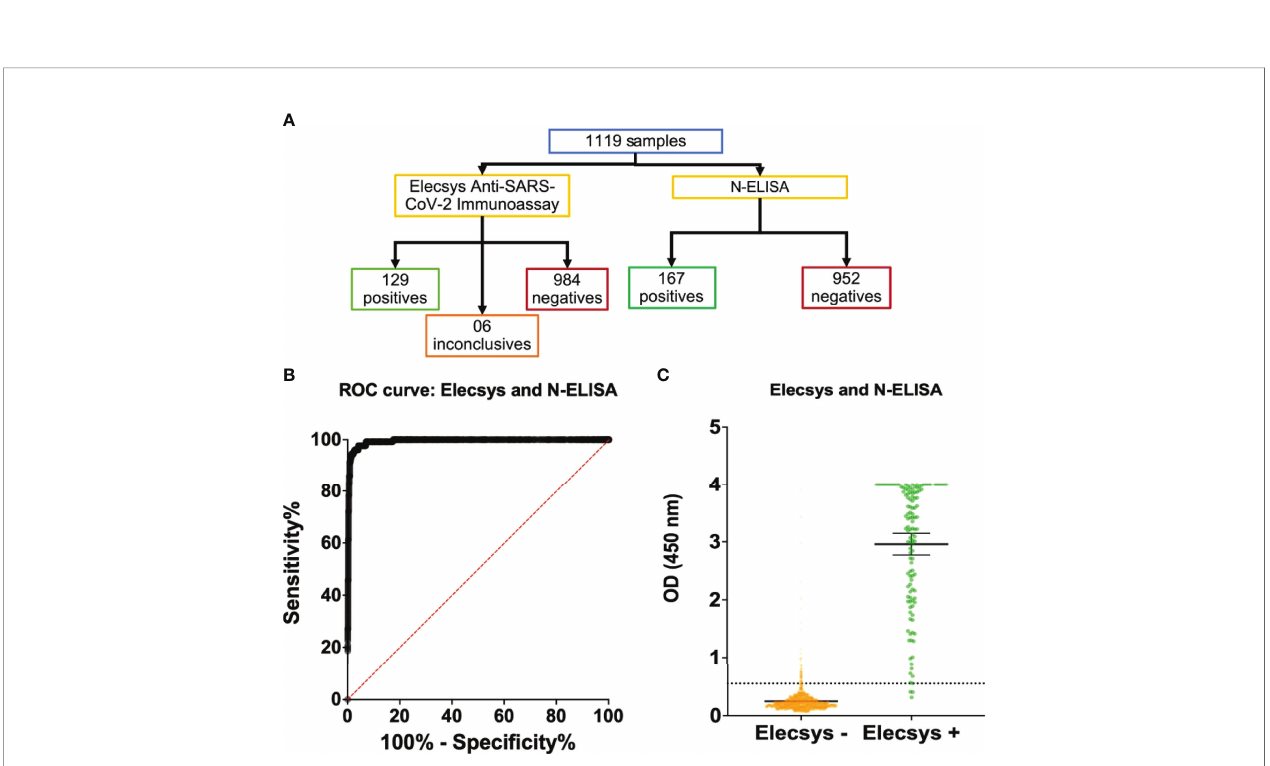
FIGURE 2 | Global human sample evaluation with Elecsys ® Anti-SARS-CoV-2 Immunoassay and N-ELISA assay. The two assays that showed best performances were chosen to be evaluated by a global sample panel in the study. (A) Flow chart indicating the total evaluated samples and positive, inconclusive or negative results for Elecsys ® Anti-SARS-CoV-2 Immunoassay and N-ELISA assay. (B, C) ROC curve (B) and samples individual data (C) of N-ELISA assay performance with regard to Elecsys ® Anti- SARS-CoV-2 Immunoassay as gold standard